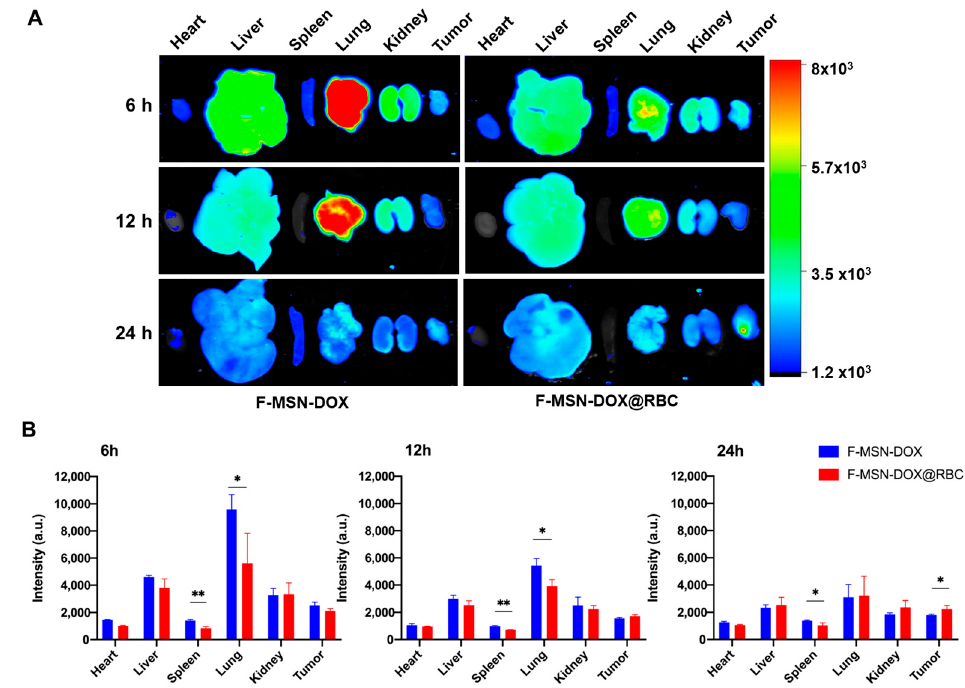
Figure 5. In vivo biodistribution of F-MSN-DOX and F-MSN-DOX@RBC. ( A ) Representative images of major organs. ( B ) Fluorescence quantification results at varied times. ** p < 0.01, * p < 0.05, n = 6.